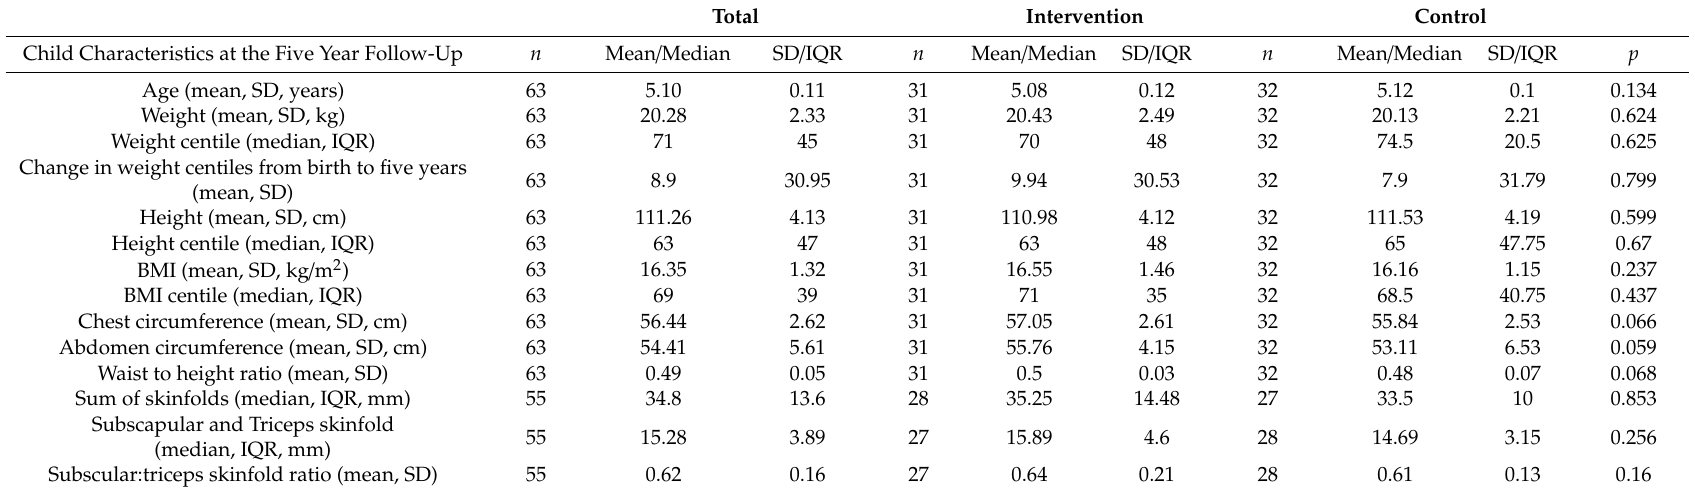
Table 2. Characteristics of o ff spring born into the intervention and control groups in the ROLO cohort at five years of age. Total Intervention Control Child Characteristics at the Five Year